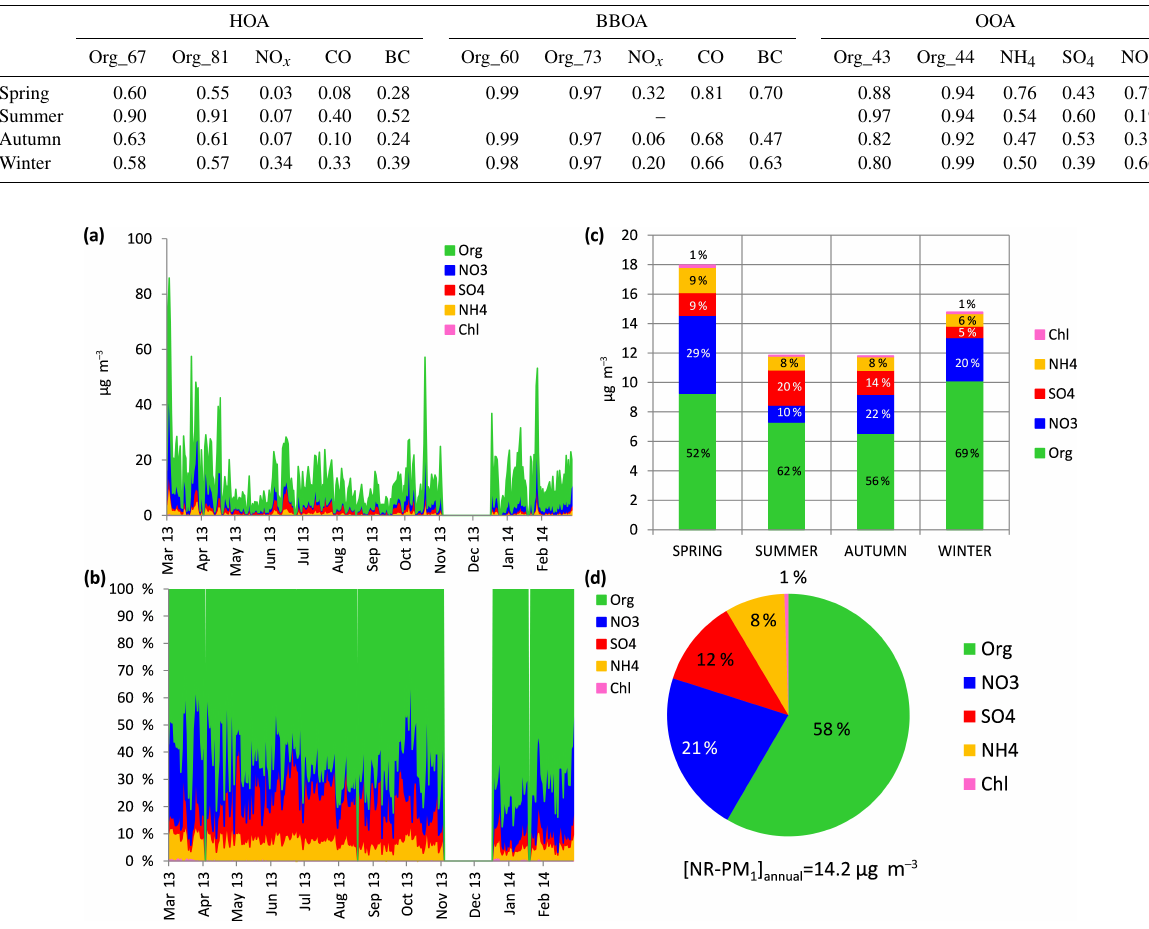
Figure 3. Overview of the chemical composition of NR-PM 1 at Ispra (Po Valley, Italy): daily absolute (a) and relative (b) chemical compo- sition; seasonal (c) and annual (d)